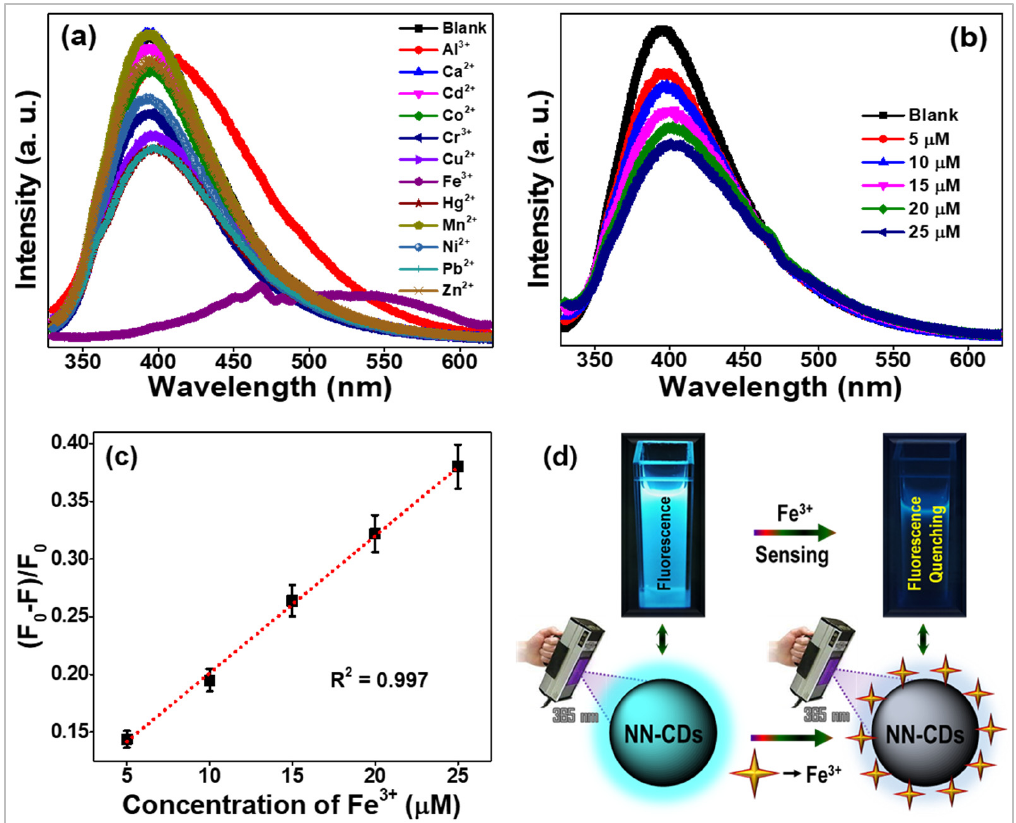
Figure 6. ( a ) Fluorescence emission changes of the aqueous solution of NN-CDs with the addition of various metal ions at a concentration of 500 μ M. ( b ) Fluorescence intensity of the aqueous solution of NN-CDs with different concentrations of Fe 3+ ions (0 (blank), 5, 10, 15, 20, and 25 μ M). ( c ) The Stern–Volmer plot of the aqueous solution of NN-CDs with increasing concentrations of Fe 3+ ions. ( d ) Digital photographs of aqueous NN-CD suspension before and after adding Fe 3+ ions under 365 nm UV light illumination (upper) and a schematic representation of the fluorescence emission quenching triggered by the chelation of Fe 3+